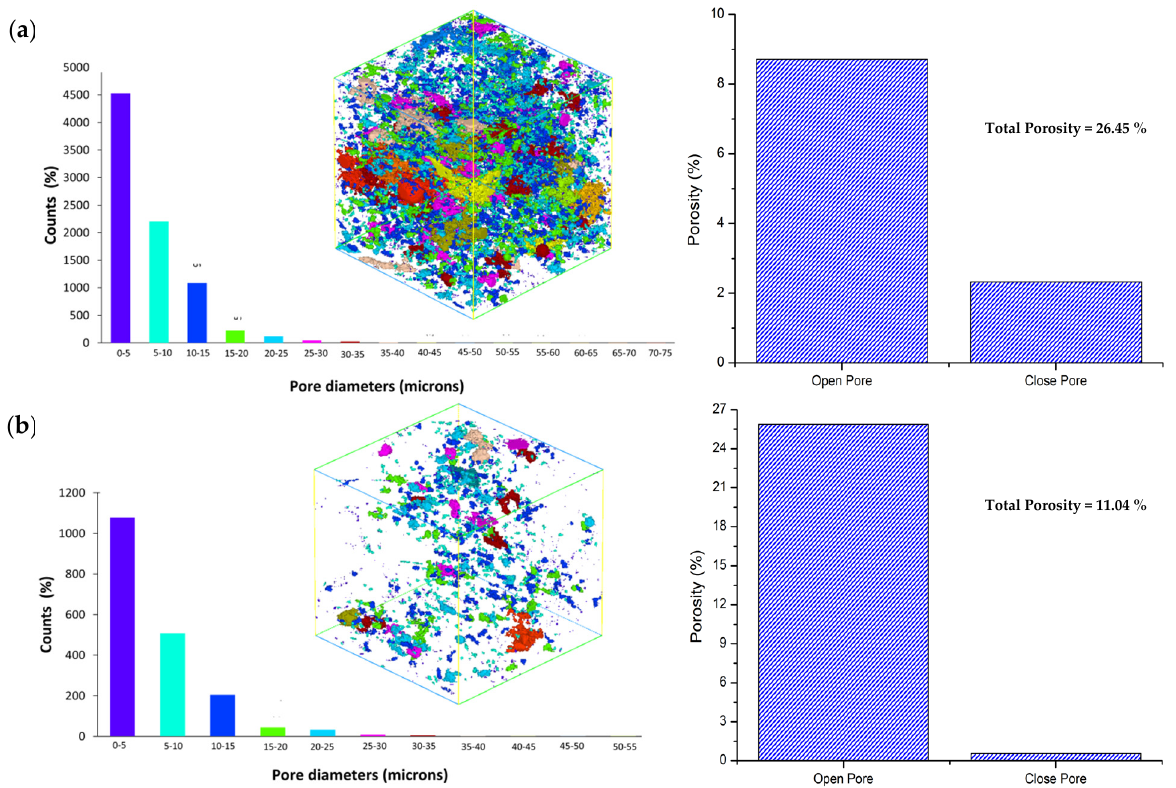
Figure 6. Various porosity size distribution at different curing age: ( a ) 28 days; and ( b ) 10 years of fly ash geopolymer.